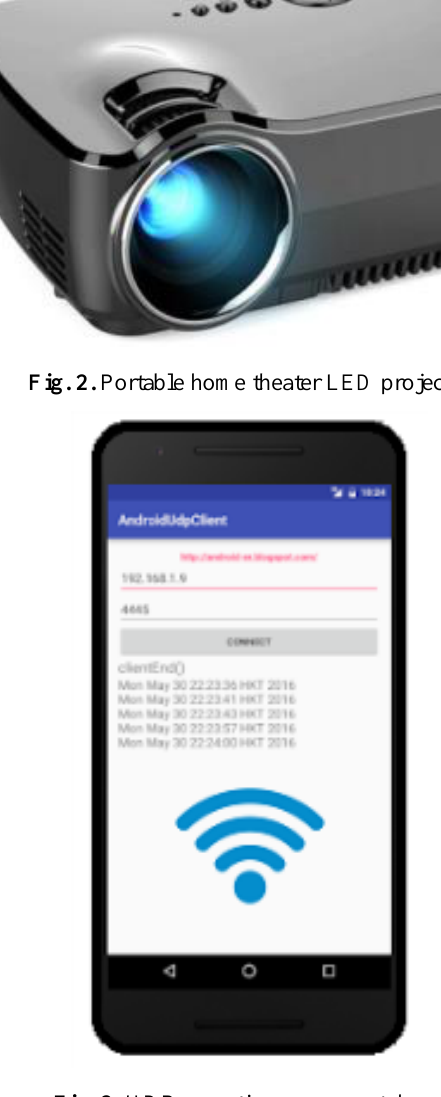
Fig. 3. UDP reception on a